Question: In one sentence, what is this figure communicating?
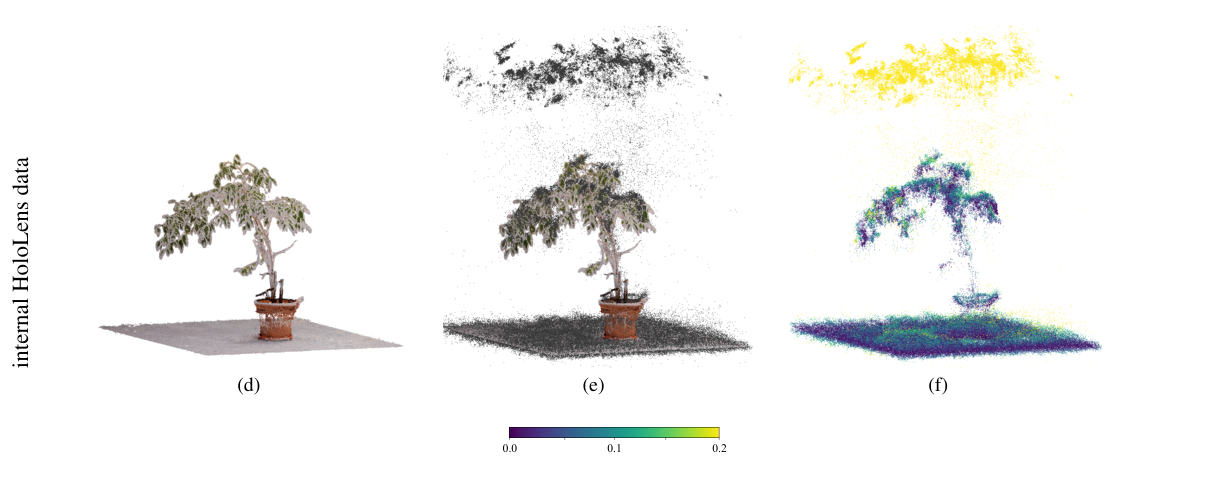
Answer: Geometric accuracy via Chamfer Distance ↓. Reference point cloud from MVS compared to the point clouds from Gaussian Splatting by extracting the center of each Gaussian. Top: Scene ’Ficus’ with external SfM data. From left to right: (a) Reference, (b) reference and GS point cloud, (c) Chamfer Distance of the GS point cloud. Bottom: Scene ’Ficus’ with internal HoloLens data. From left to right: (d) Reference, (e) reference and GS point cloud, (f) Chamfer Distance of the GS point cloud.